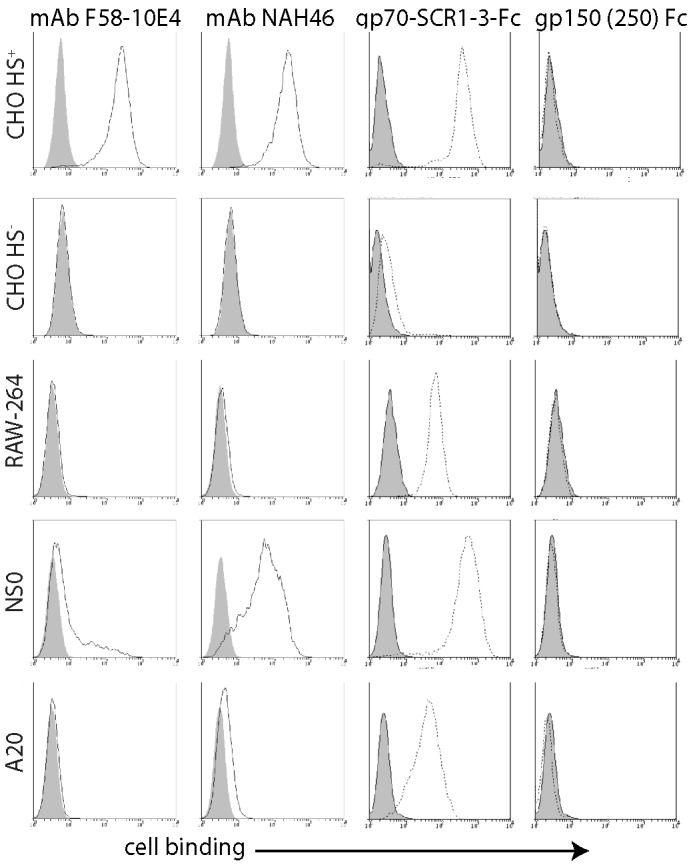
Flow cytometric assay of cell surface HS expression.Cells were plated overnight onto Petri dishes, then detached without trypsin and stained with HS-specific mAbs (F58-10E4, NAH46) or with the HS binding N-terminal 3 SCR domains of the virion gp70 linked to human IgG-Fc. The N-terminal 250 amino acids of gp150 linked to IgG-Fc provided a negative control. Open histograms show specific staining; filled histograms show staining by secondary antibody alone. Equivalent data were obtained in a repeat experiment.